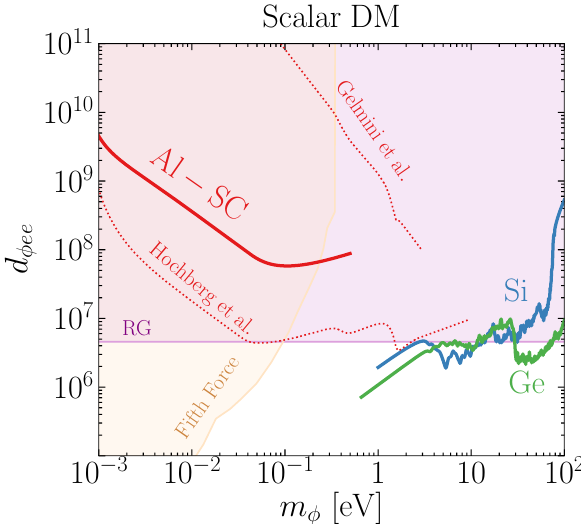
Figure 3 . Projected 95% C.L. reach (3 events with no background) with semiconductor crystal (Si, Ge) and superconductor (Al-SC) targets, for the scalar DM model defined in eq. (2.3), assuming 1 kg-yr exposure. In contrast to the vector and pseudoscalar cases shown in figure 2, the projections here cannot be derived from the target’s optical properties. Differences compared to Hochberg et al. [24] and Gelmini et al. [38] in the Al-SC case are discussed in detail in section 5. Also shown are existing constraints from fifth force [88] and red giant (RG) cooling